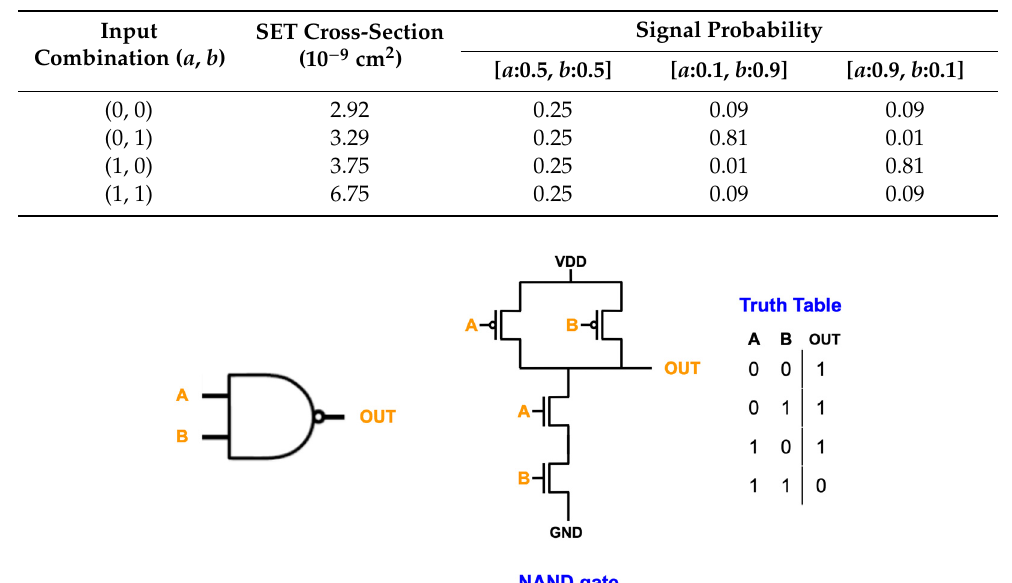
Table 1. Input combination, SET cross-section under 78.23 MeV · cm 2 / mg, and three signal probability